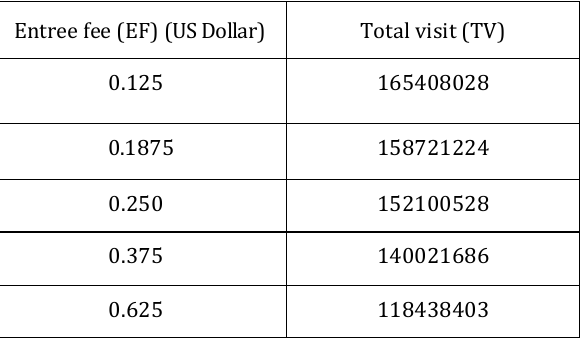
Table 2. Entrance fee and total visit